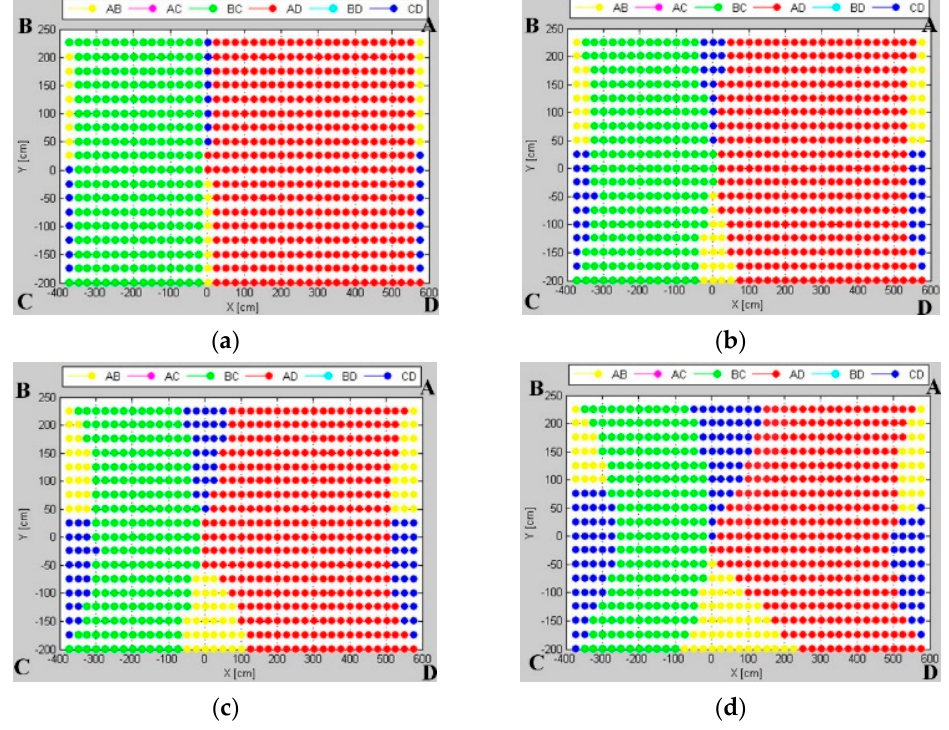
Figure 10. Uncertainty map for test environment TE2 with different uncertainty varying component coefficients: ( a ) 0.1; ( b ) 0.5; ( c ) 1.0; and ( d ) 2.0. The reference point was not located symmetrically.